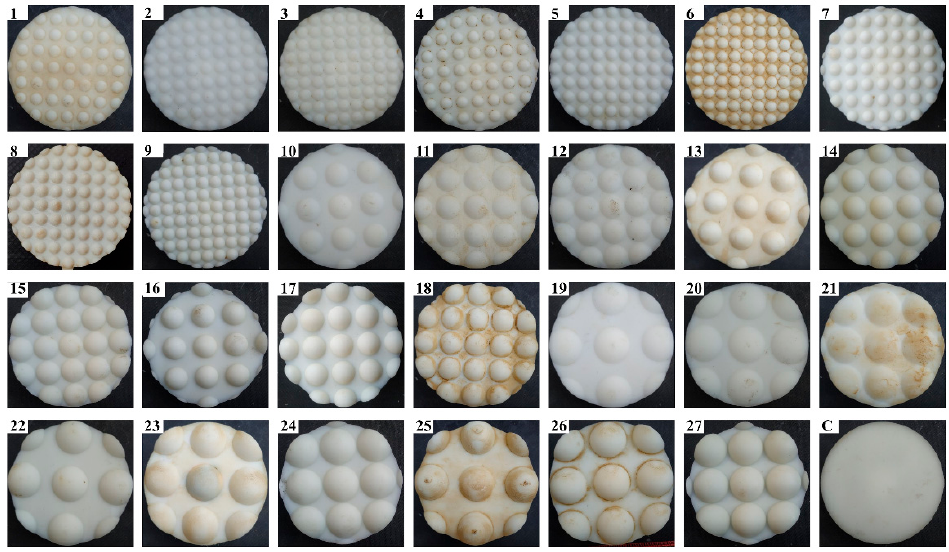
Figure 3. The full factorial design of control parameter levels according to the L27 (3 3 ) Taguchi orthogonal array, in addition to the flat disc (C), which uses as a control.